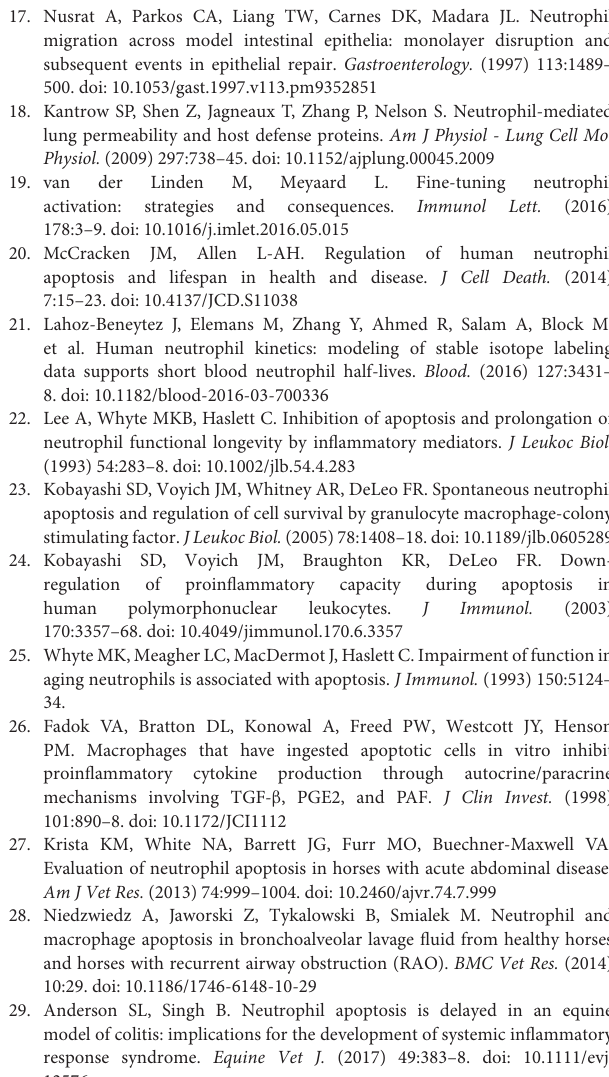
cytometry quantification of annexin V binding and propidium iodide staining. No statistical analyses performed on raw data. Supplementary Figure S3 | Raw percentages of neutrophil viability, apoptosis, death after 24-h incubation. Mean (SEM) percentages of live (A) , apoptotic (B) and dead (C) neutrophils following 24-h treatment of equine neutrophils under GM-CSF-primed or unprimed ( n = 6 horses) conditions. Flow cytometry quantification of annexin V binding and propidium iodide staining. No statistical analyses performed on raw data. Supplementary Figure S4 | Withaferin A decreases overall respiratory burst in neutrophils stimulated with PMA or insoluble immune complexes (IIC). Mean (SEM) luminescence area under the curve (AUC) in neutrophils pretreated with WFA, VC, or media control under PMA [ (A) n = 5 horses], IIC [ (B) n = 5 horses], or GM-CSF/LPS [ (C) n = 6 horses] stimulation. Luminol-enhanced chemiluminescence detection of reactive oxygen species for 90 minutes post-stimulation. One-tailed paired t -test of VC neutrophils; ### p < 0.001 compared to unstimulated VC. One-way repeated measures ANOVA (Holm-Sidak multiple comparison testing); ∗ p < 0.05, ∗∗ p < 0.01, as compared to VC within same stimulation condition.